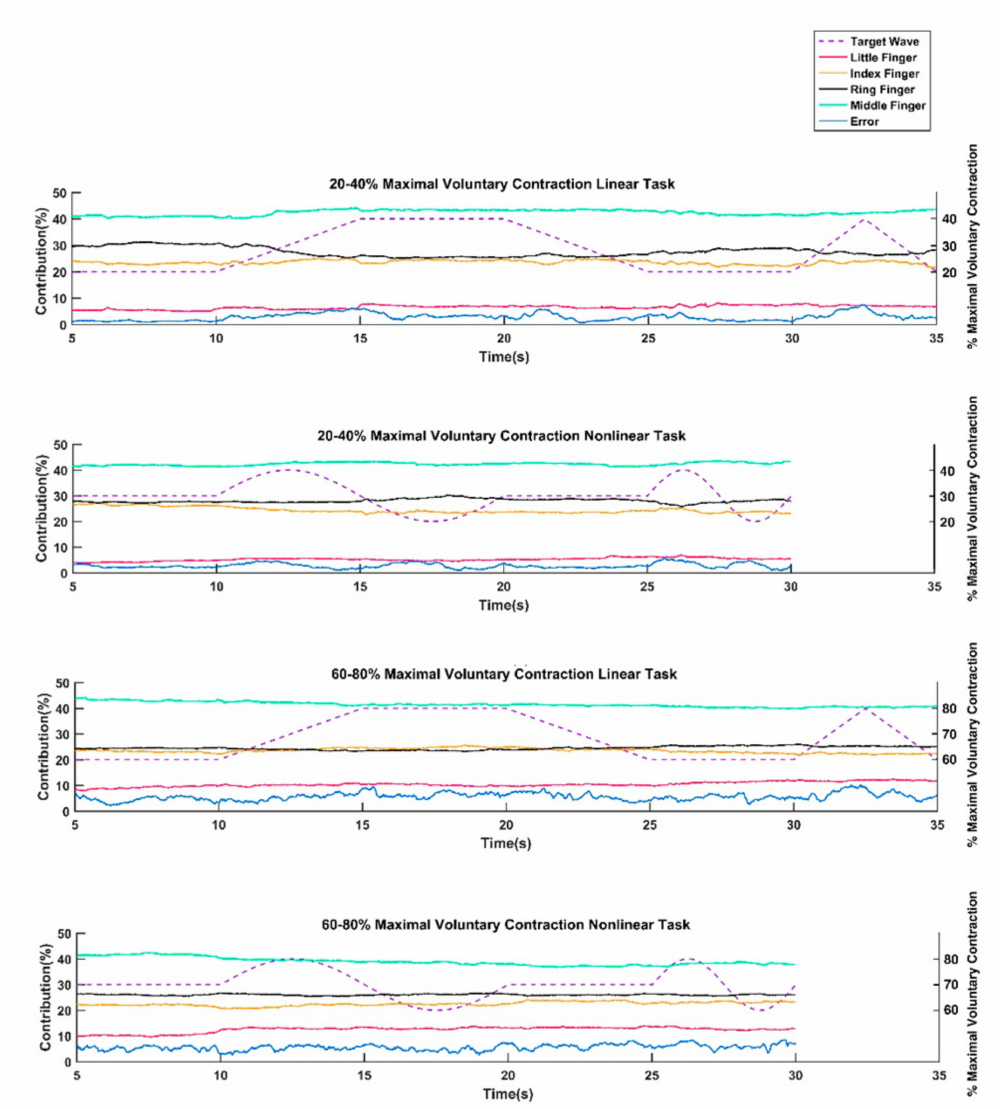
Figure 3. Curves of target force (TW), individual force contribution (FC), and following error (FE) in different force following tasks. Values of force contribution and following error refer to the left vertical axis, and values of target wave refer to the right vertical